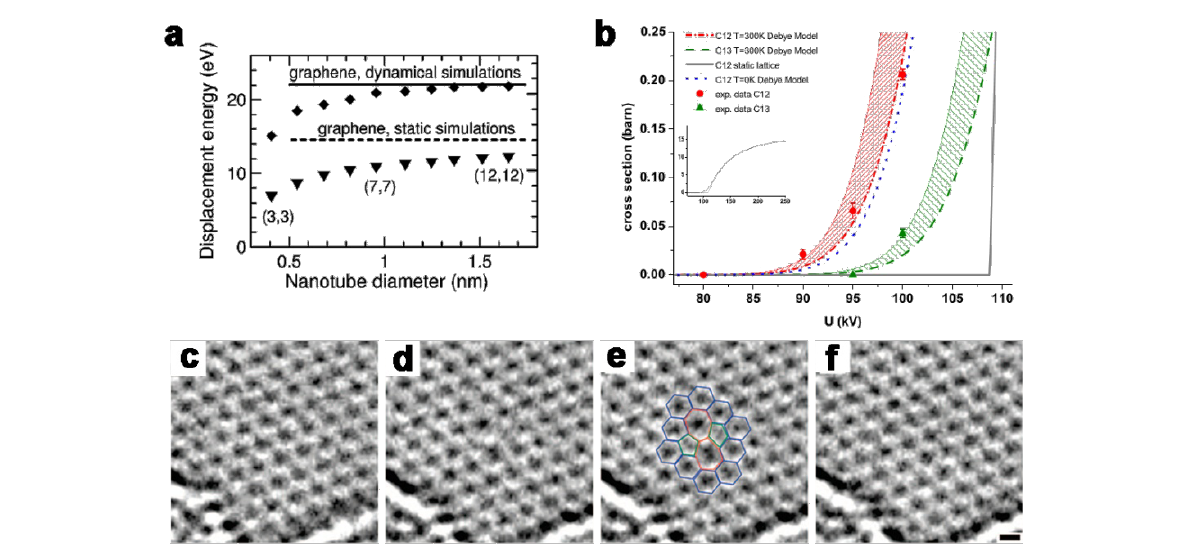
Figure 3: (a) Threshold energy T d needed to displace carbon atoms from armchair multi-walled carbon nanotubes (SWCNTs) and graphene calcu- lated dynamically (diamonds) and statically (triangles) as a function of tube diameter; the lines are the corresponding results for graphene; repro- duced with permission from [33], Copyright (2005) American Physical Society. (b) Measured and calculated knock-on displacement cross sections. The lower boundary of the shaded areas corresponds to the calculated cross section, while the upper boundary is twice the calculated value. The inset shows the calculations for 12 C, 300 K and static lattice on a larger energy range; reproduced from [35], Copyright (2012) American Physical Society. (c–f) Metastable Stone–Wales (SW) defects found in HRTEM image sequence: (c) unperturbed lattice before appearance of the defect, (d) SW defect, (e) same image with atomic configuration superimposed, (f) relaxation to unperturbed lattice (after ca. 4s); reproduced with permission from [37], Copyright (2008) American Chemical